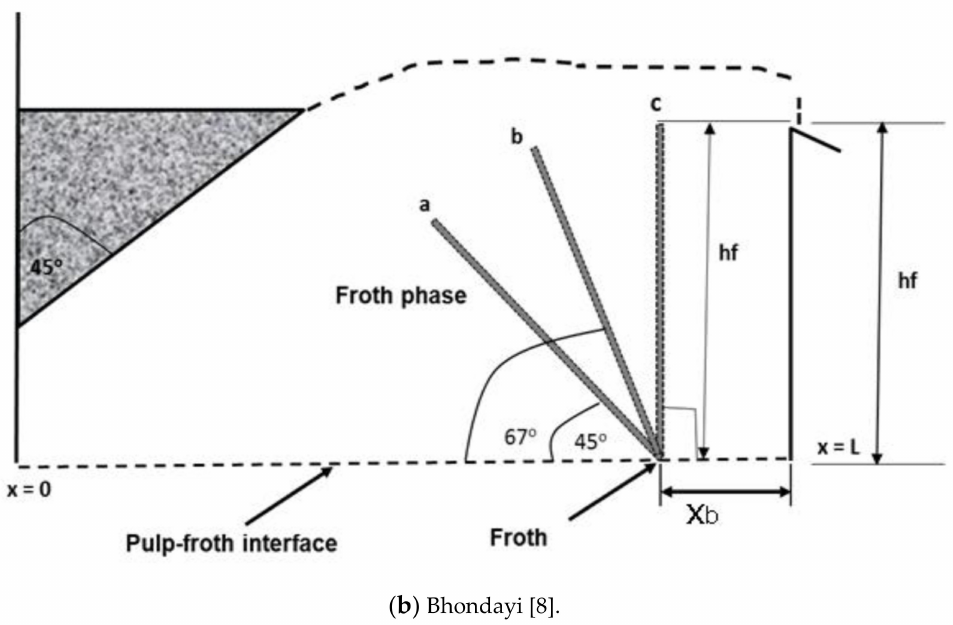
Figure 19. Physical froth flow modifiers: ( a ) Moys [7]; ( b ) variants, by Bhondayi